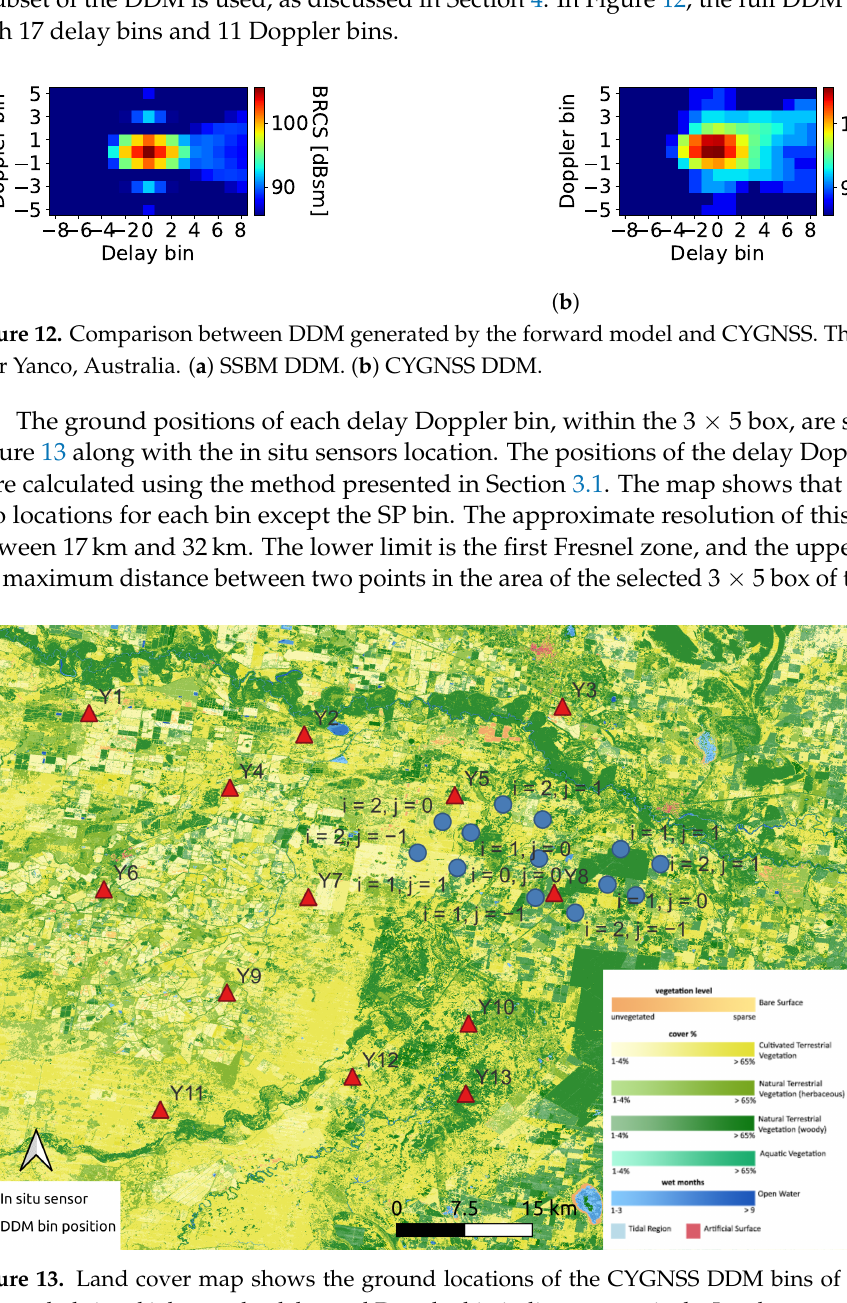
Figure 13. Land cover map shows the ground locations of the CYGNSS DDM bins of Figure 12. The symbols i and j denote the delay and Doppler bin indices, respectively. Land cover map source is